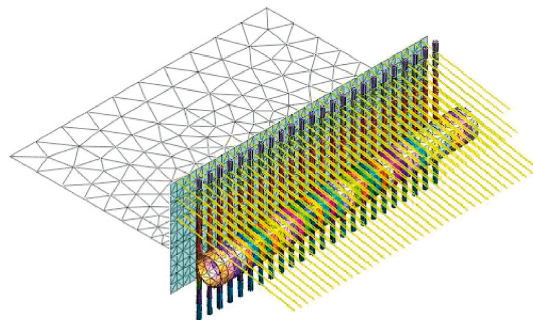
Figure 10: Mesh of isolation piles and supporting